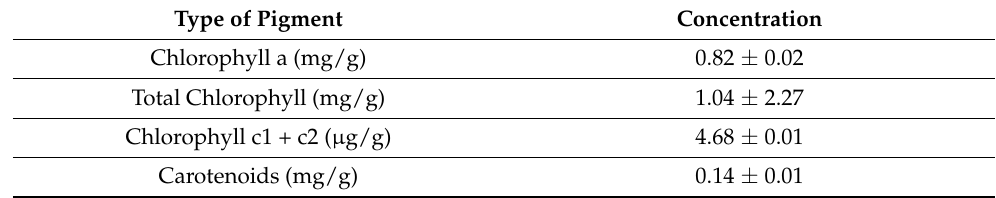
Table 3. Quantitative analysis of the photosynthetic pigments present in J. rubens .